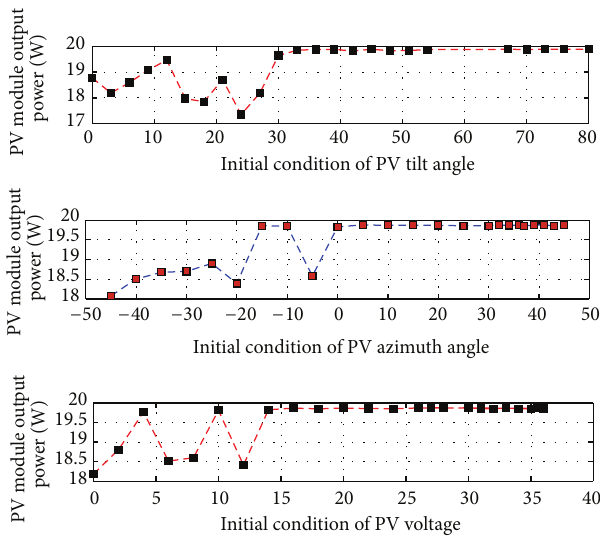
Figure 11: The optimal PV module power at changing the initial population in GA at